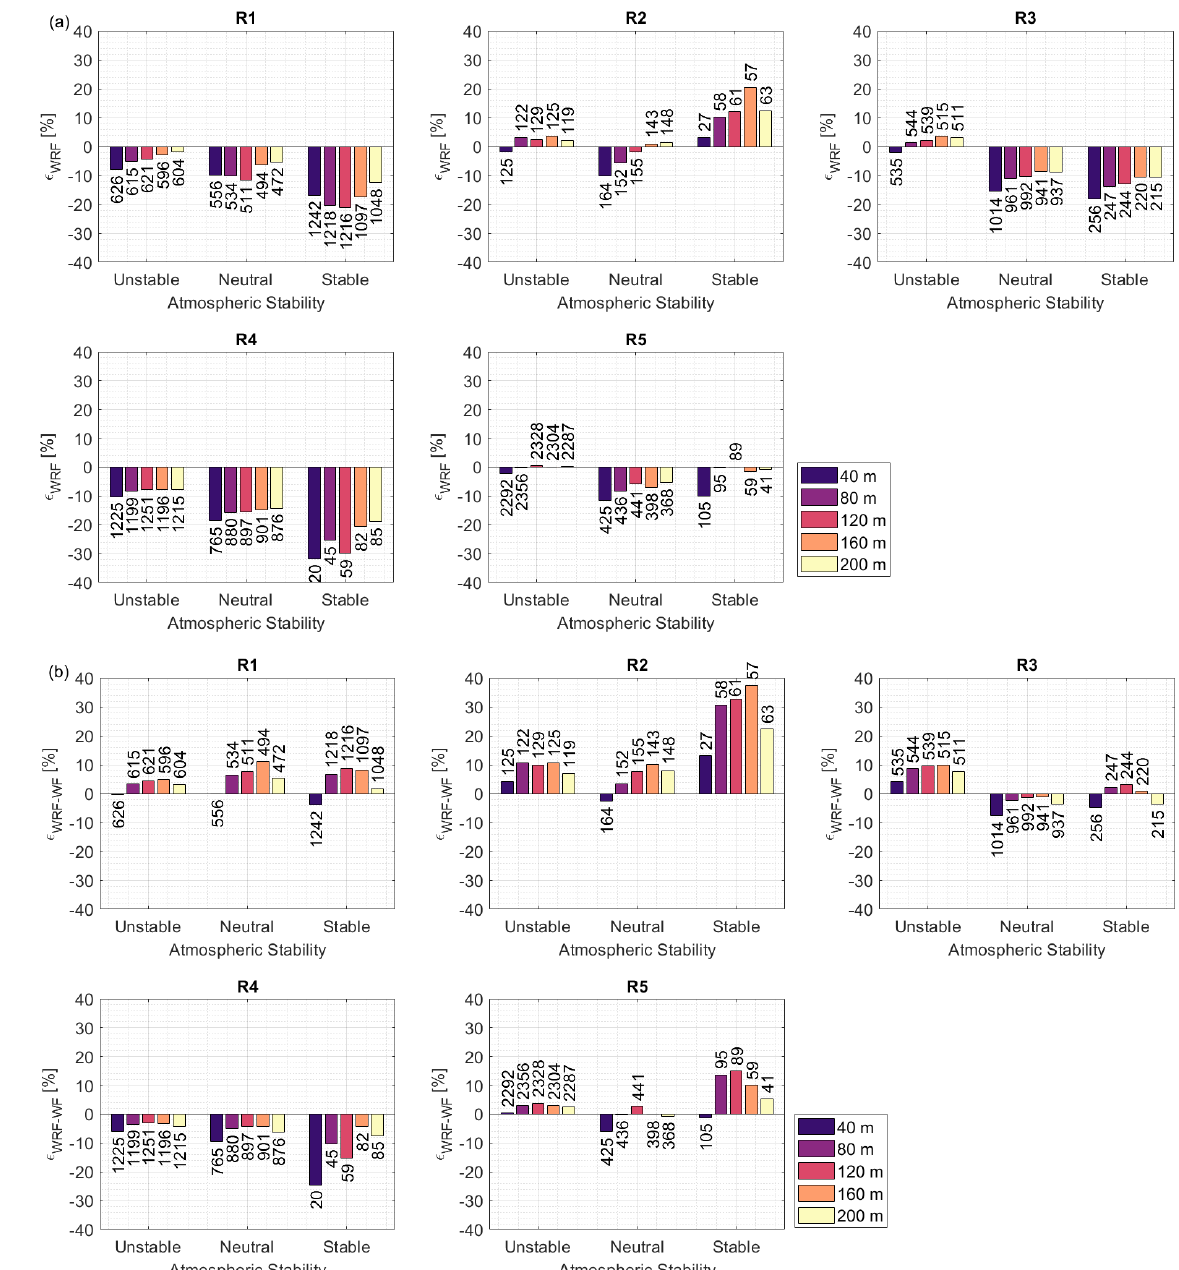
Figure 13. The deficit (cid:15) WRF (Eq. 2) in the wind speed between the lidar measurements and WRF model for (a) no wind farm parameterization u diff (WRF) and (b) with the wind farm parameterization (cid:15) WRF-WF for regions R1 to R5; for each measurement height 40, 80, 120, 160 and 200m; and for each stability class. The number below and above each bar indicates the number of 10min wind speed values.